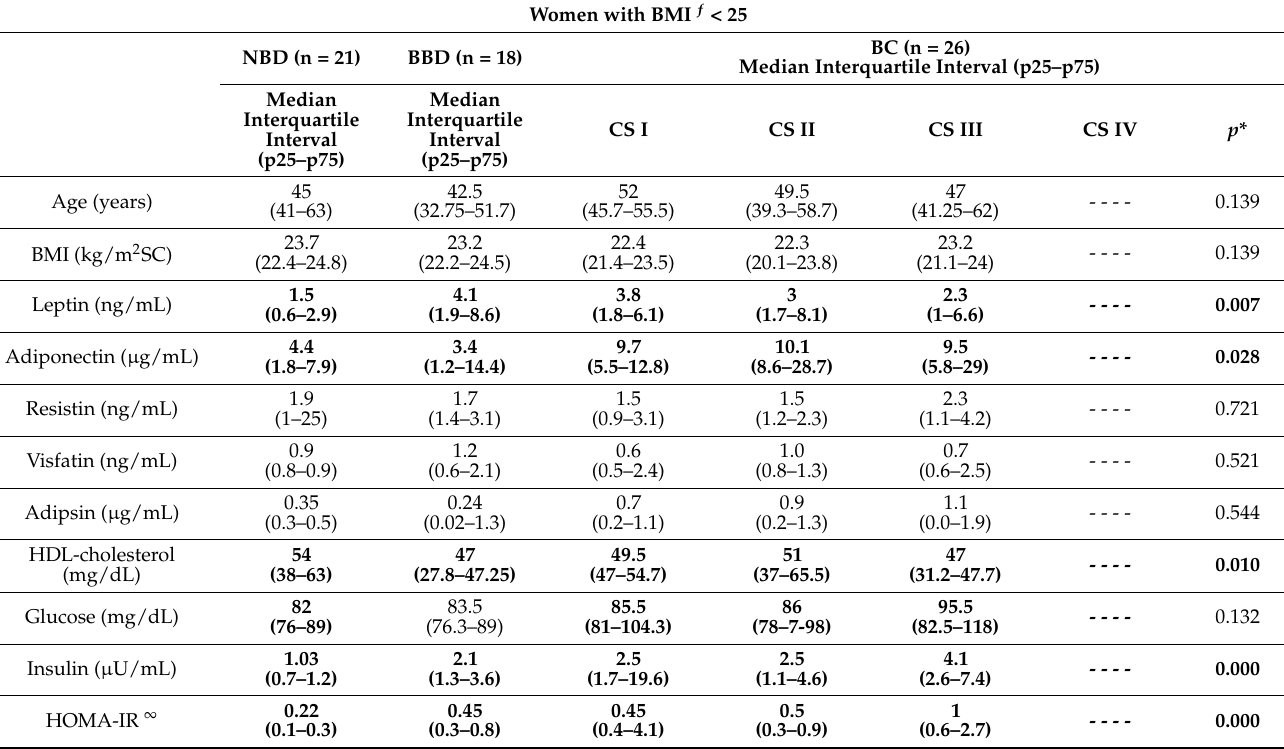
Table 4. Biochemical and metabolic indicators in a group of over-40-year-old Mexican women undergoing mastographic screening. Women with BMI ƒ <